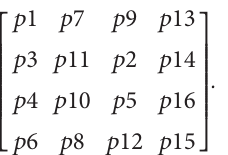
Figure 4: State transition of